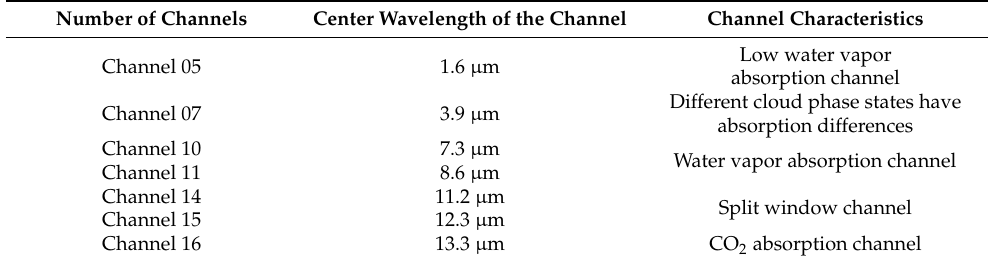
Table 1. Selected AHI